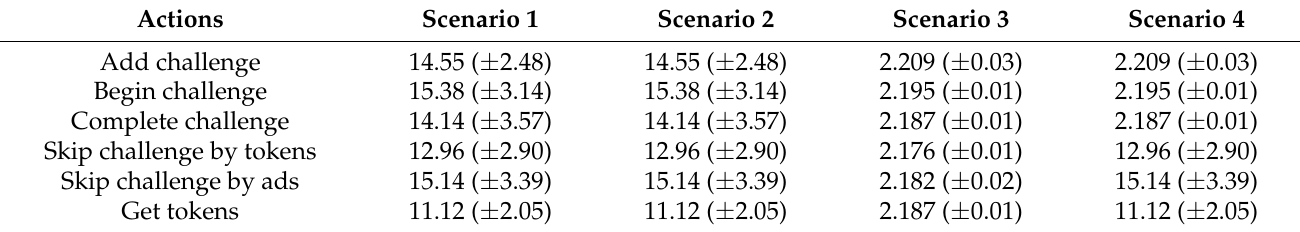
Table 3. Mean response time units for write requests (confidence intervals).